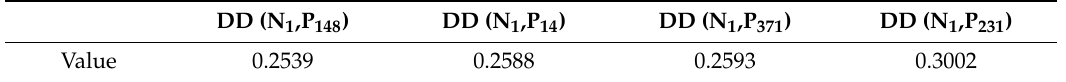
Table 4. The result of data deviation between the new case and retrieved past